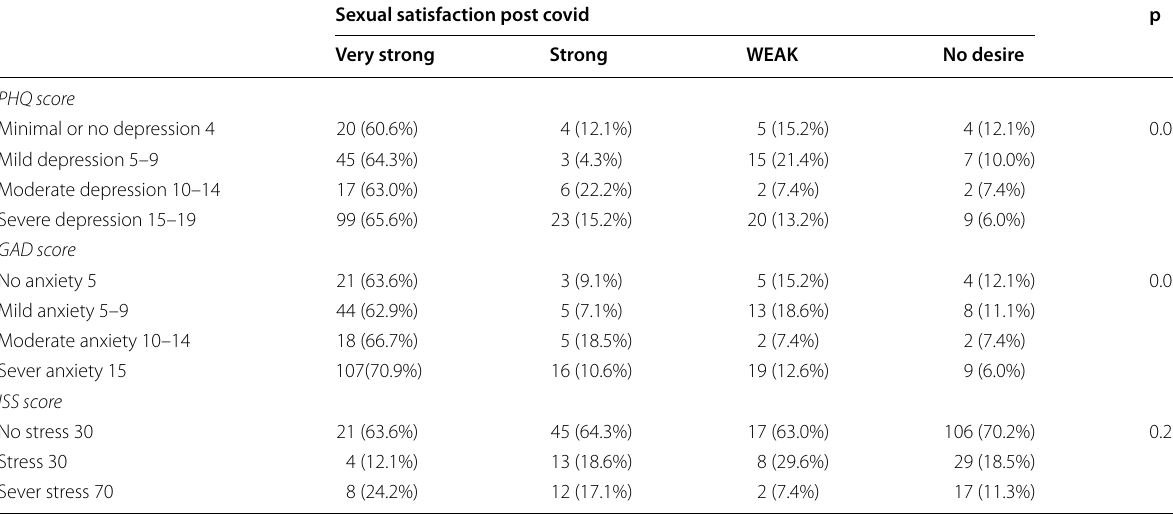
Table 2 Correlation of PHQ score, GAD score, and ISS score to covid outbreak